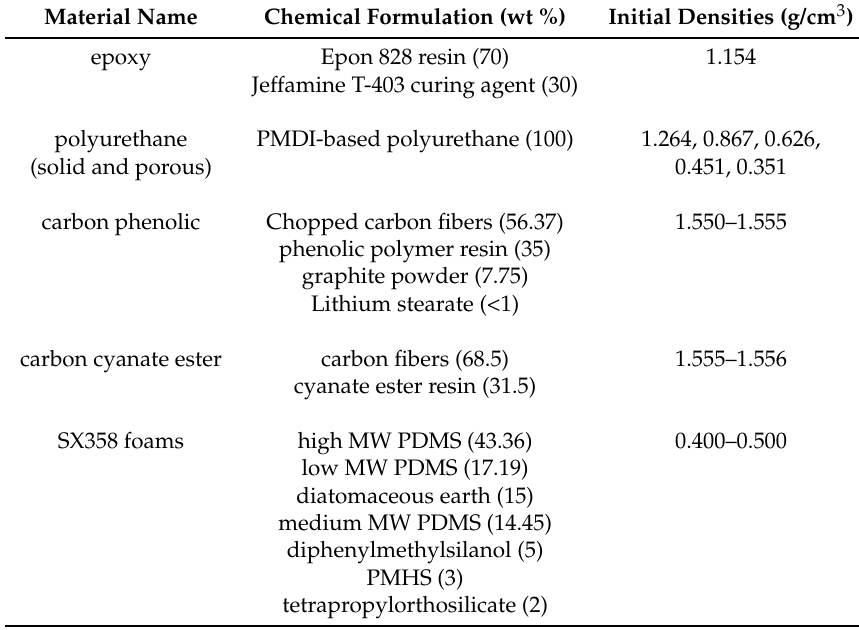
Table 1. Polymers and foams discussed in the Results section. All materials were manufactured